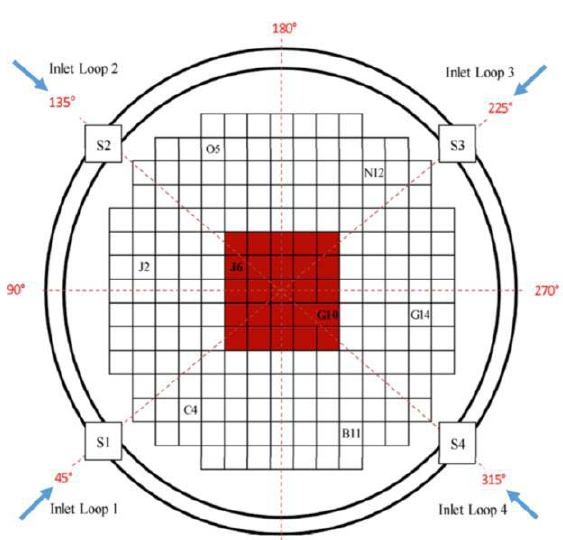
Figure 1: Radial layout of the sensor strings (i.e. O5, N12, J2, J6, G10, G14, C4, and B11), the four inlet coolant loops, and vibrating fuel elements (i.e. red